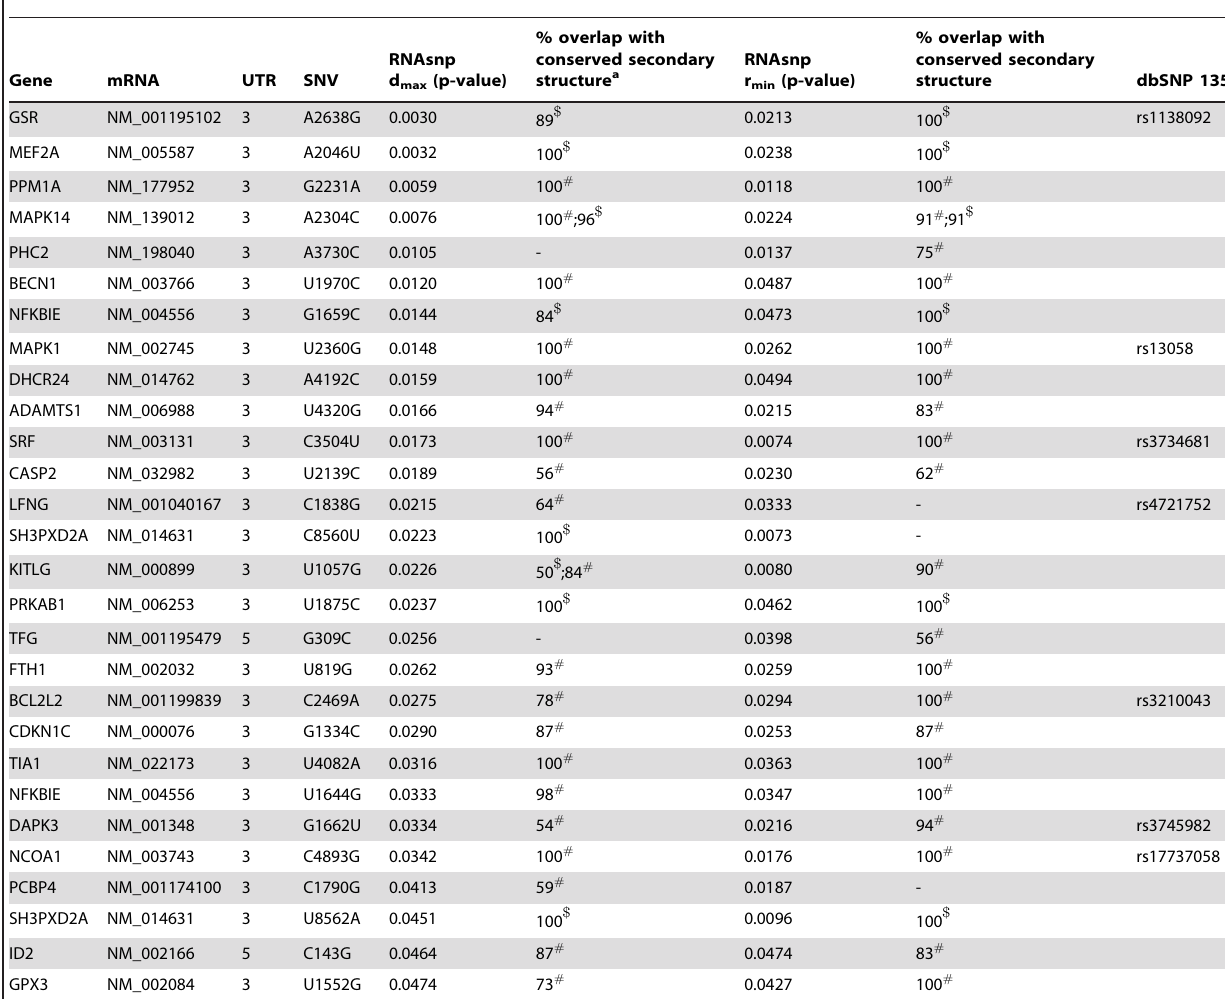
Table 1. List of 28 high-confidence SNVs with p-value , 0.05 predicted by both d max and r min measures of